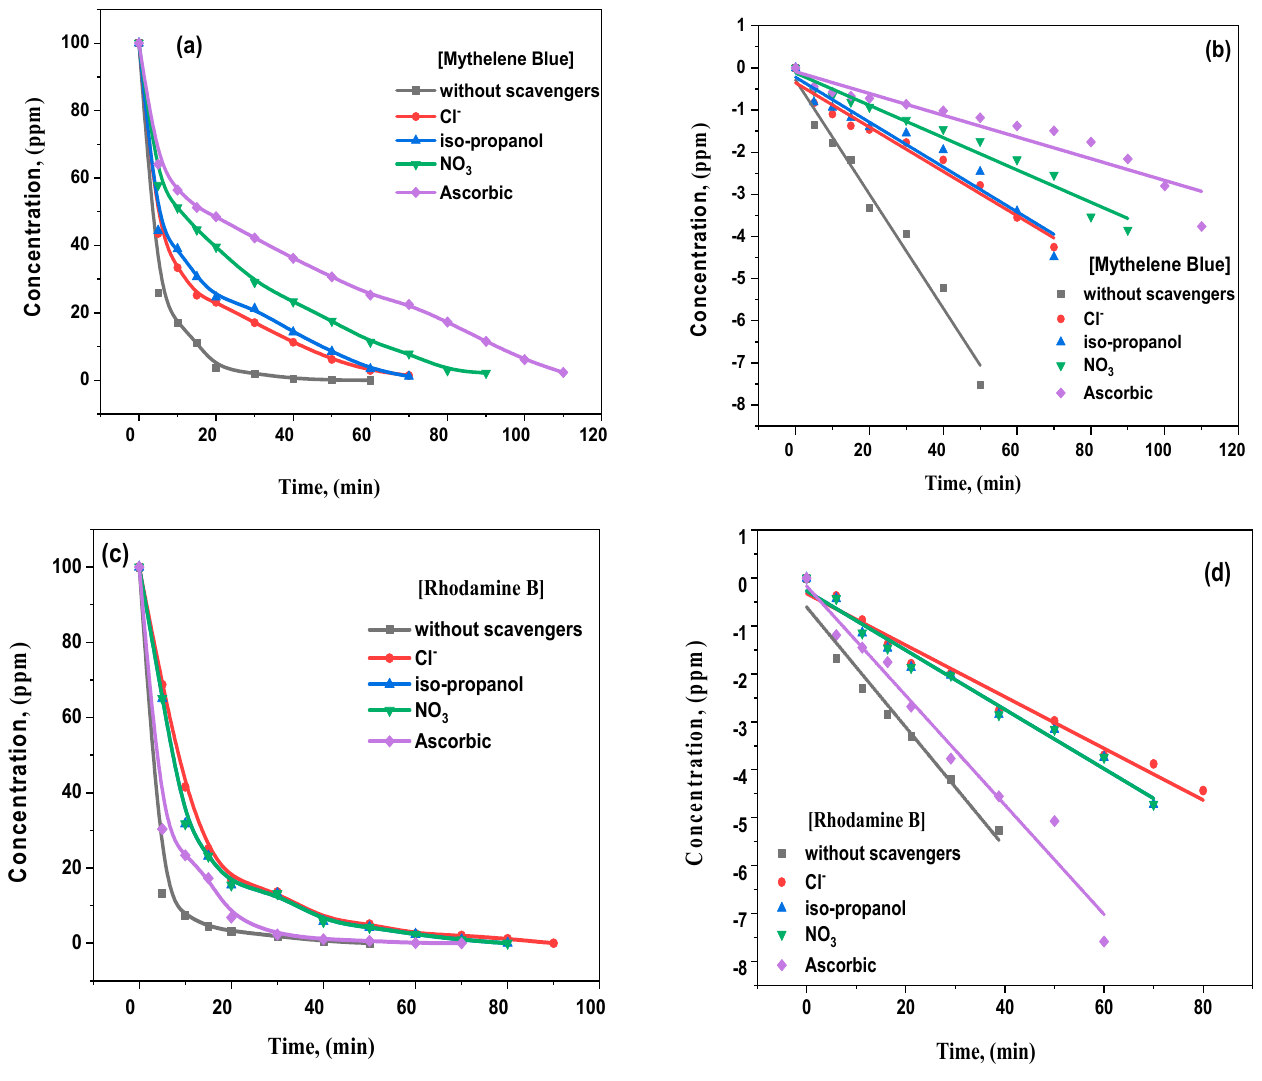
Figure 11. ( a – d ): Influence of different scavengers on the photocatalytic activity of pure ZnO and La 2 O 3 -ZnO nanostructured